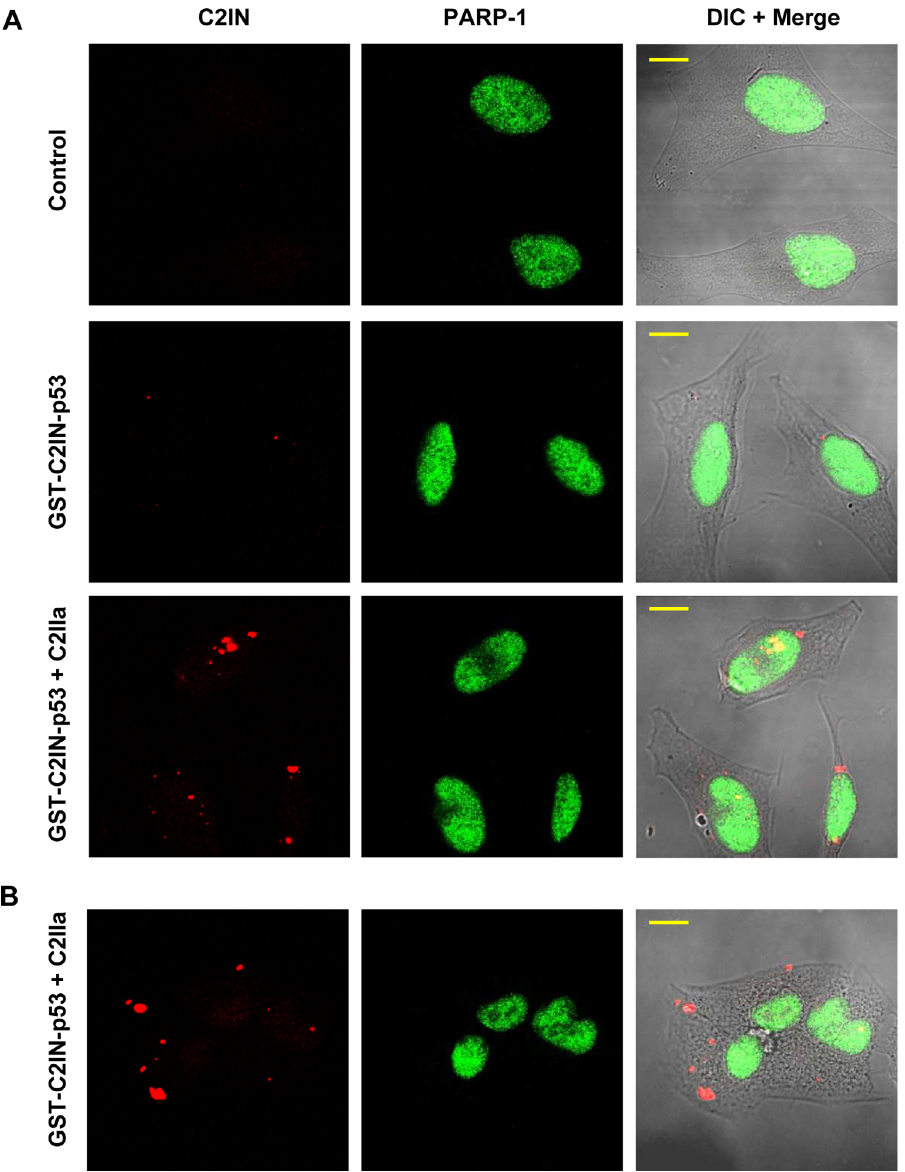
Figure 4. Subcellular localization of internalized GST-C2IN-p53 in HeLa and A549 cells. A . Confocal microscopy of GST-C2IN-p53 uptake in HeLa cells. Cells were treated with GST-C2IN-p53 and C2IIa for 5 h. As control, cells were left untreated or incubated without C2IIa. Subsequently, cells were fixed, permeabilized and stained for C2IN with a polyclonal antibody followed by an Alexa 633-coupled secondary antibody (red). PARP-1 was detected with a monoclonal antibody and subsequent staining by an Alexa 488-conjugated secondary antibody to visualize the nuclei (green). Z- Stack images were recorded in 0.75 m m optical sections and processed by ImageJ. Representative images thereof are shown. Scale bar: 10 m m. B . Delivery of GST-C2IN-p53 into A549 cells. Cells were treated and processed as described above. Z-Stack images were acquired in 0.75 m m optical sections and processed by ImageJ. Representative images thereof are shown. Scale bar: 10 m m.